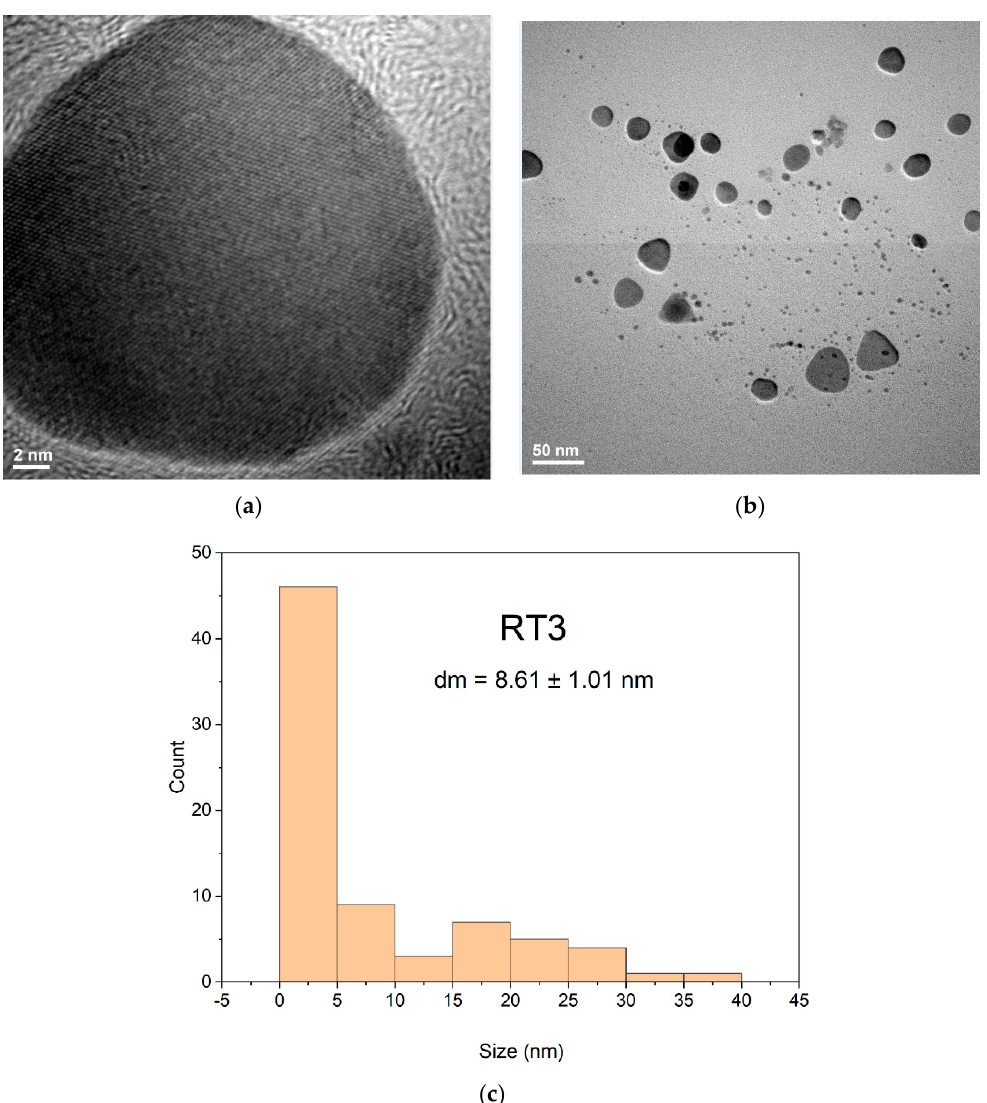
Figure 7. TEM images for AgNPs sample coded RT3 at two different magnifications ( a , b ) and the appropriate histogram ( c ). appropriate histogram ( c